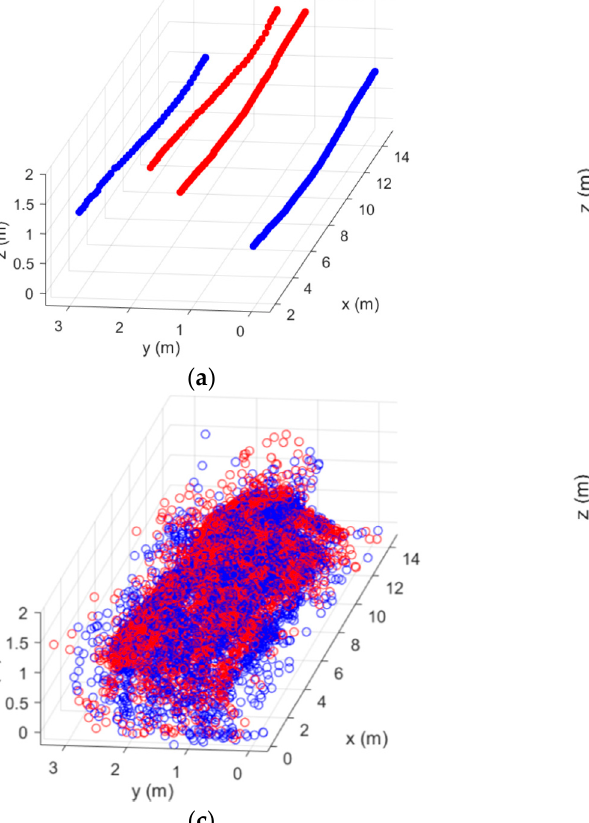
Figure 10. ( a ) Rover modules positions and ( b,c,d ) different perspectives of the point cloud retrieved from a round trip scanning path from both sides.